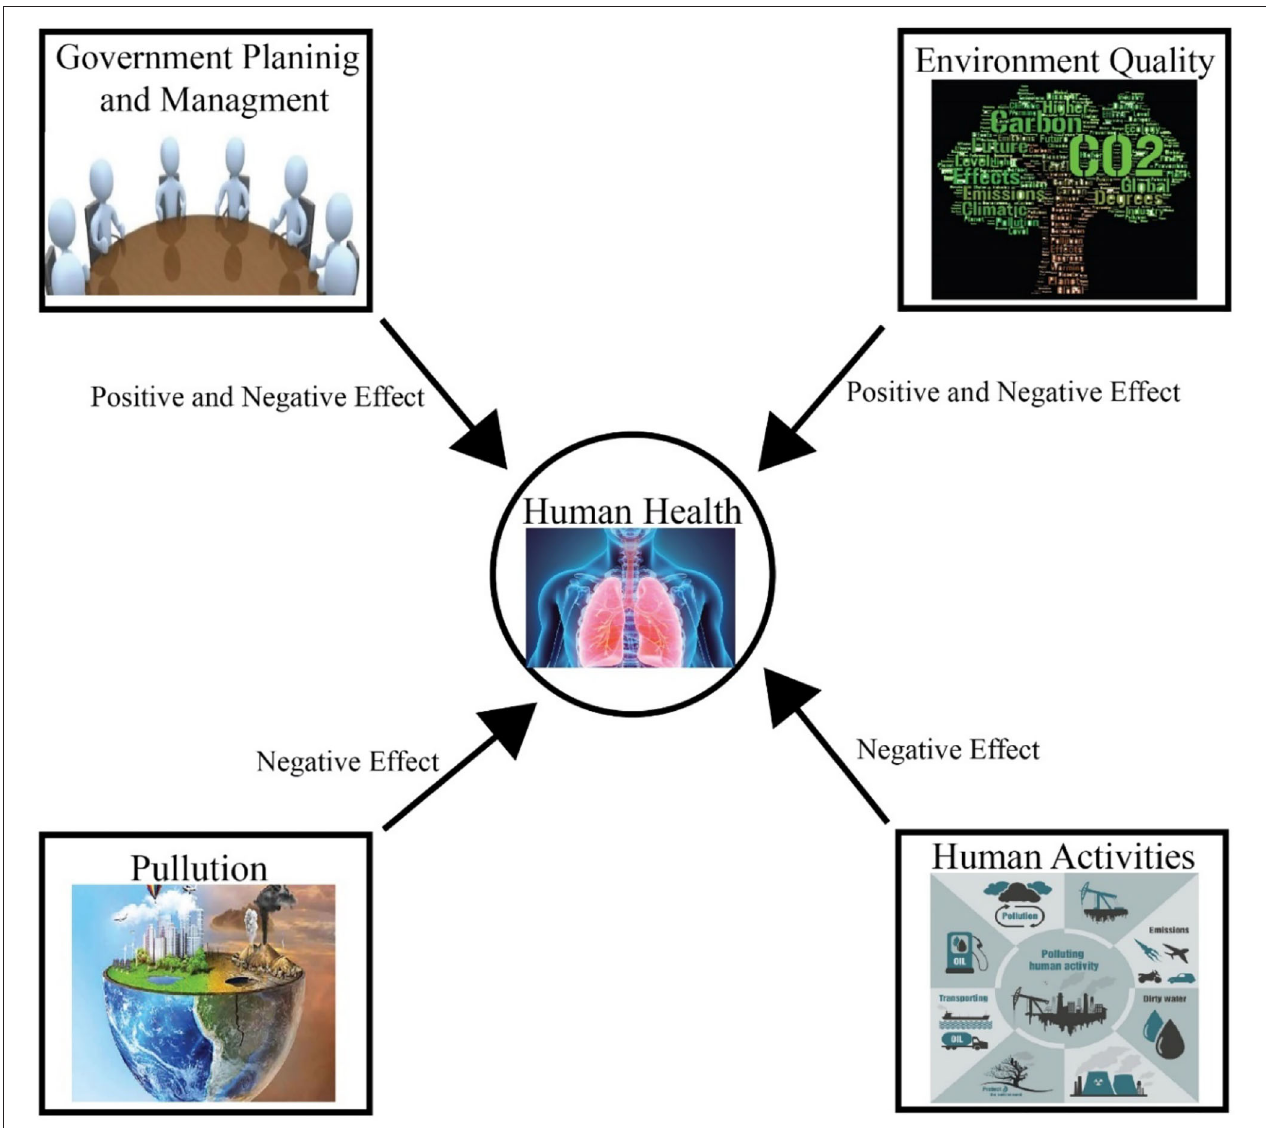
FIGURE 2 | Main factors that cause good and bad effects on human